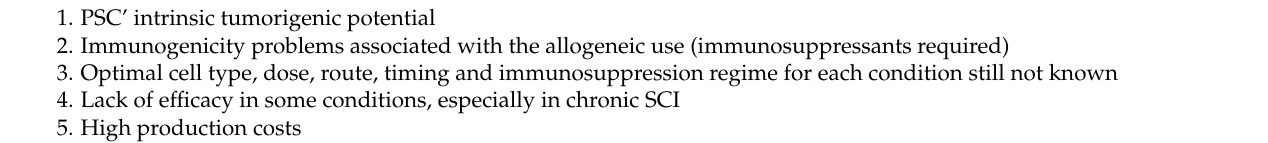
Table 3. Main challenges facing PSC-derived therapies for